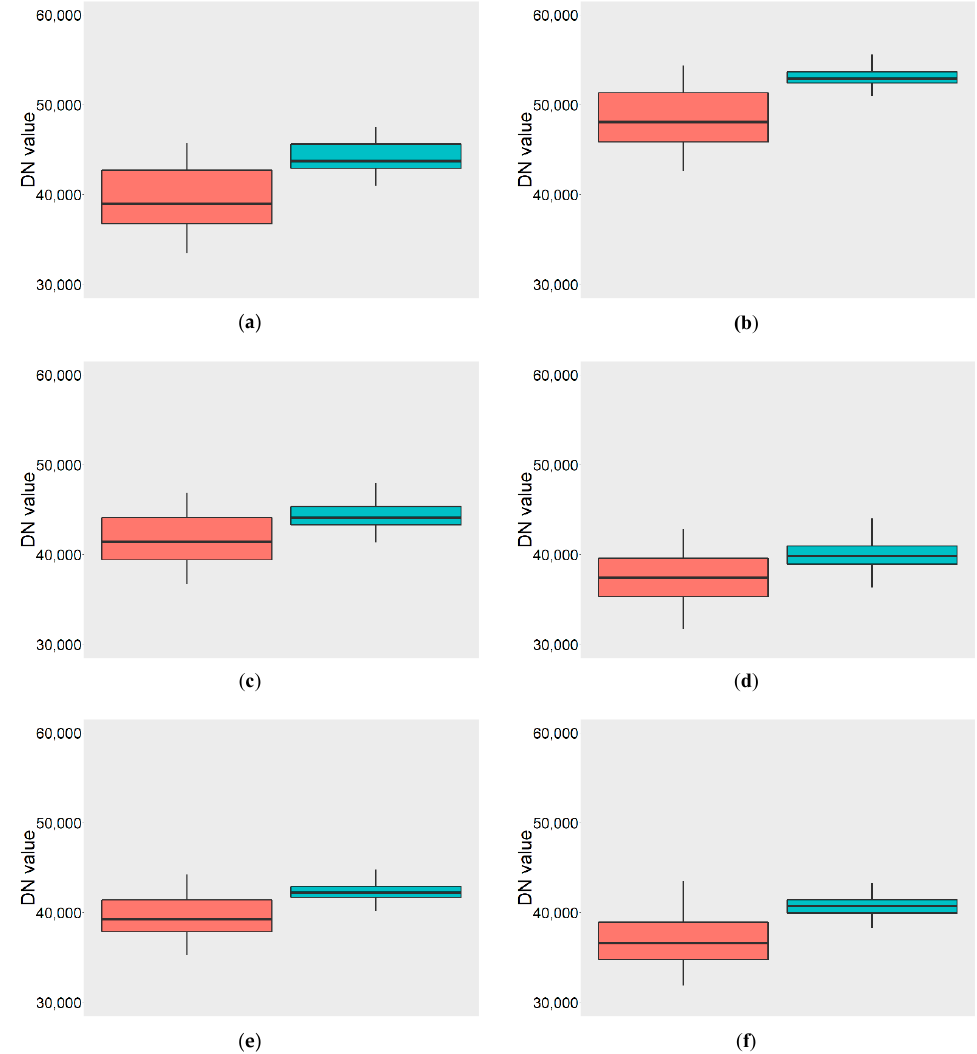
Figure 18. Variability of samples from raw image (red boxes) and corrected image (blue boxes): ( a ) Band 1; ( b ) Band 2; ( c ) Band 3; ( d ) Band 4; ( e ) Band 5; ( f ) Band 6.